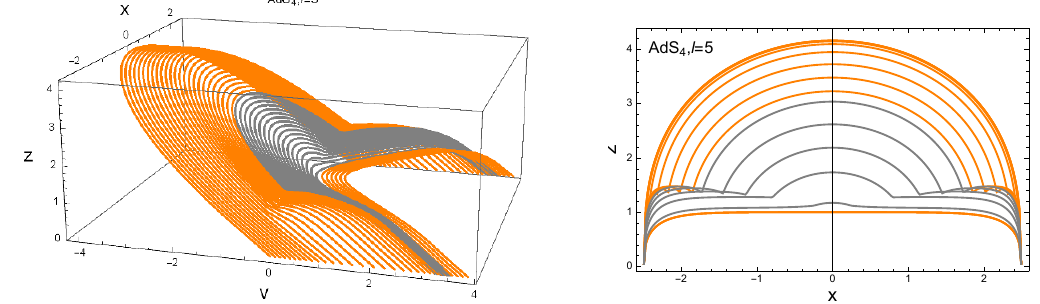
Figure 5 . The evolution of extremal surface (cid:13) A = (~ z ( x ) ; ~ v ( x )) for AdS 4 and l = 5. We (cid:12)x M = 1 and v 0 = 0 : 01